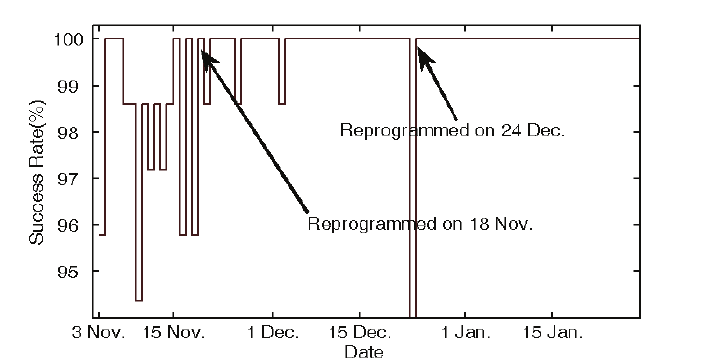
Figure 8. Average transmission success rate. System tested for three months; collectors reprogrammed twice during this